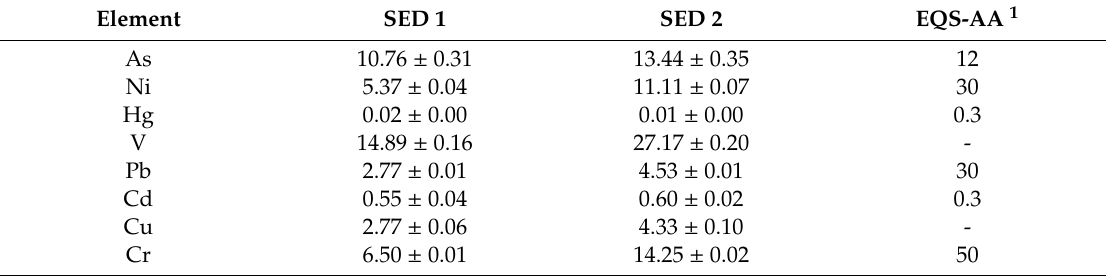
Table 4. Concentration of potentially toxic inorganic contaminants in sediments (mg kg − 1 ). Element SED 1 SED 2 EQS-AA 1 As 10.76 ±